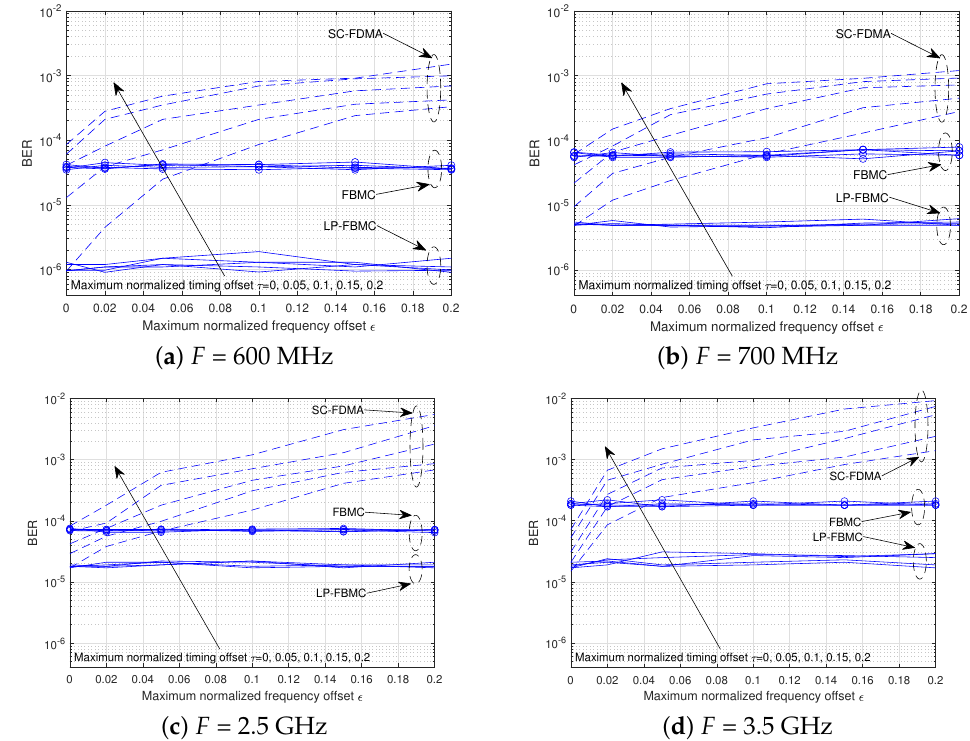
Figure 13. BER of the SC-FDMA, FBMC, and LP-FBMC, according to timing/frequency offset for various carrier frequencies, N = 64, ∆ f = 15